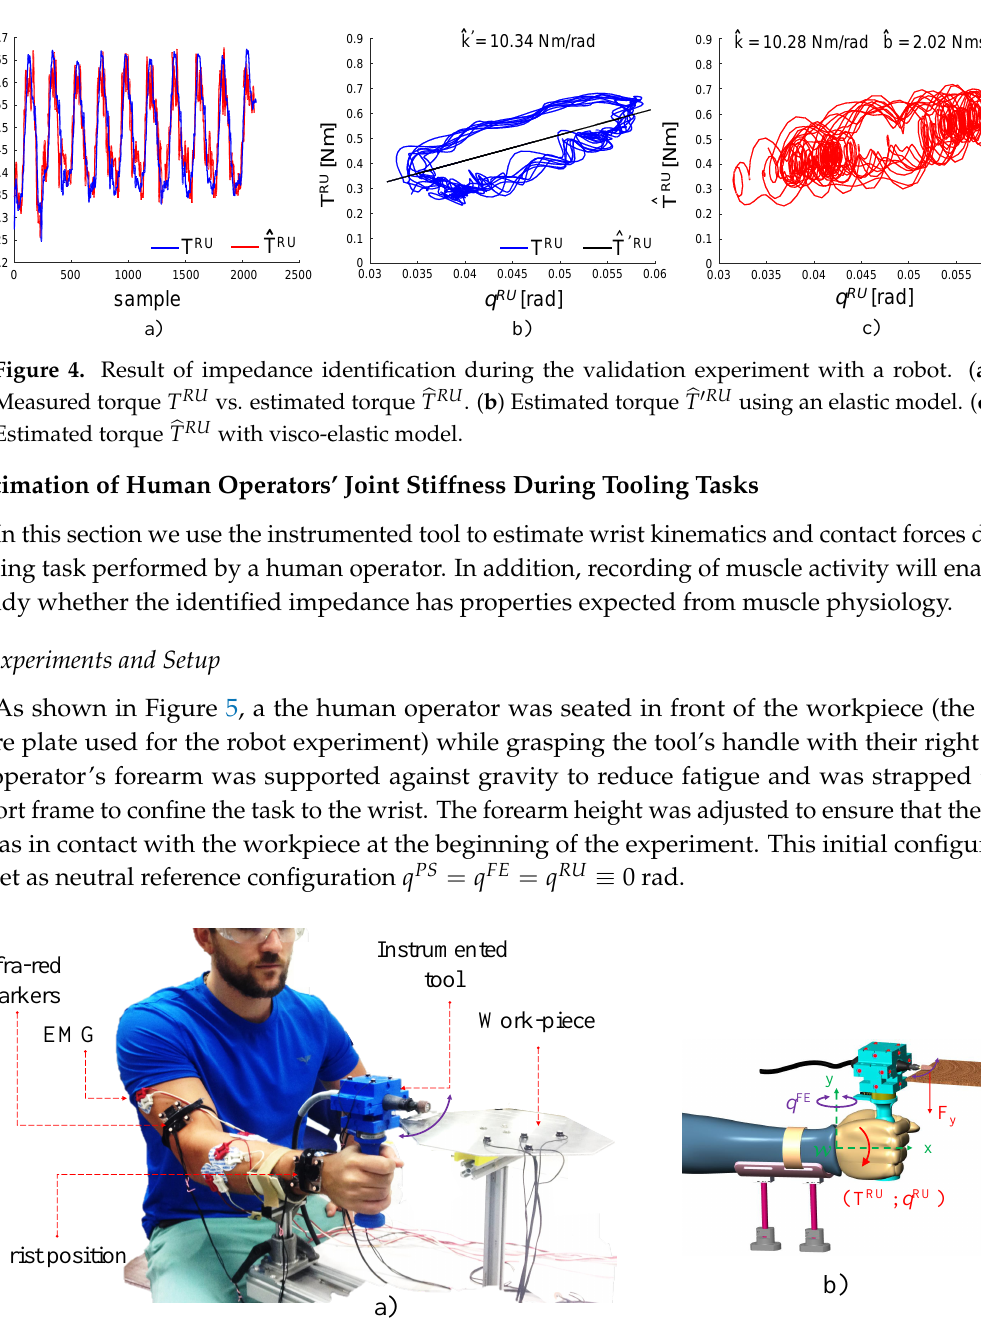
Figure 5. Human operator performing a polishing task. ( a ) Actual experimental setup. ( b ) Naming conventions. Please see online content for a video representation of the task including the visual